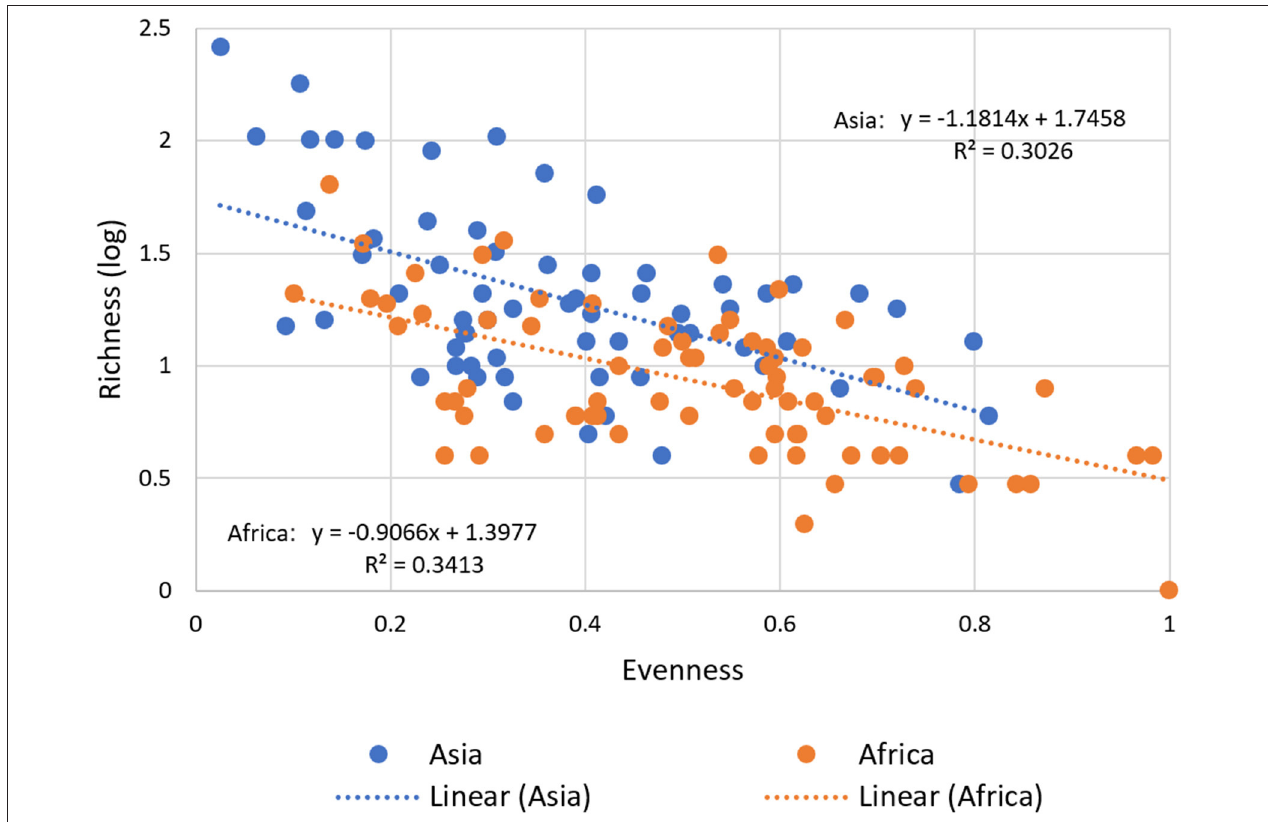
FIGURE 5 | Relationship between Varietal Richness and Evenness in Asia and Africa. For all 137 CCCs, varietal richness, calculated as the number of adopted varieties (in log), is plotted against varietal evenness and calculated as inverse Simpson E index for diversity (see Section Materials and Methods). The correlation between varietal richness and evenness is negative for the total sample ( − 0.62, P < 0.00) and for the regional sub-sample for Asia ( − 0.51, P < 0.00) and Africa ( − 0.52, P < 0.00). An inverse relationship, as predicted, is obtained using a variety-area curve (see Supplementary Figure 4 ).